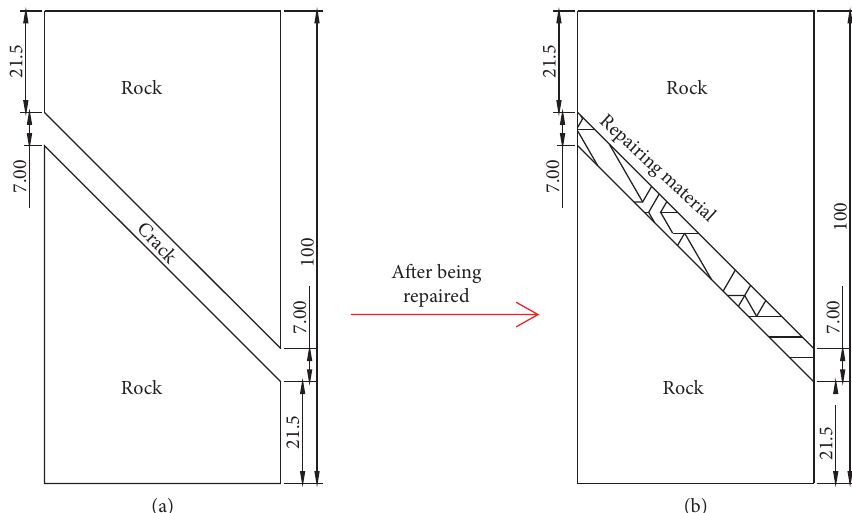
Figure 8: Schematic diagram of the sample (a) before repair and (b) after repair (unit: mm).